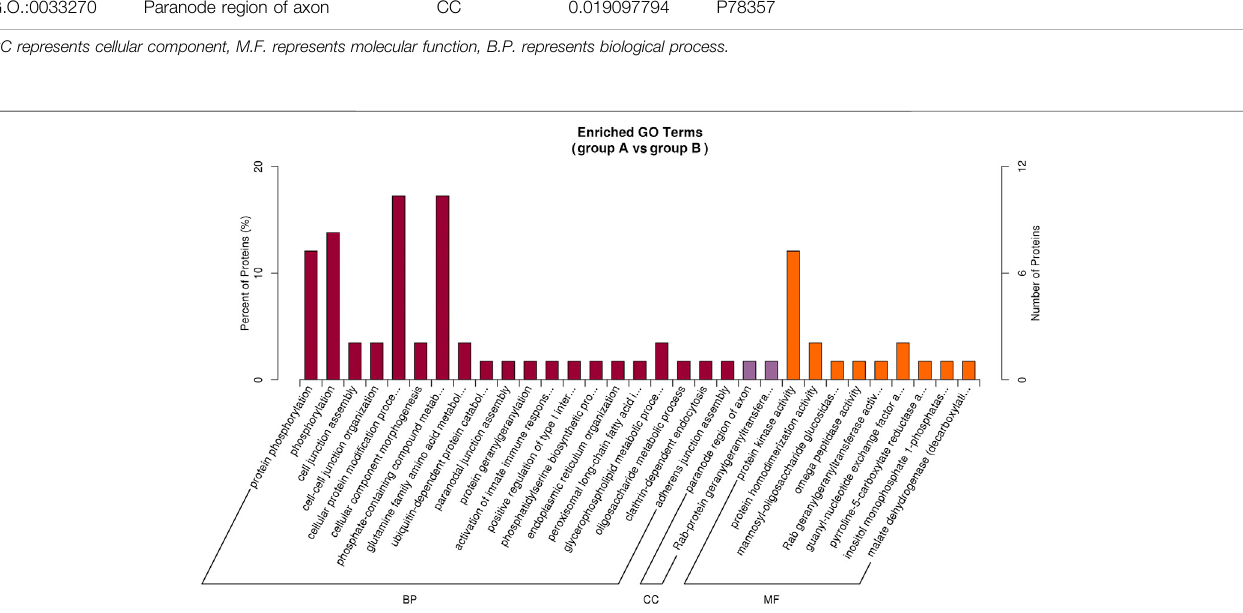
( Table 2 ). The top 20 enriched KEGG pathway terms were presented by a scatter plot ( Figure 6 ). The details of all KEGG